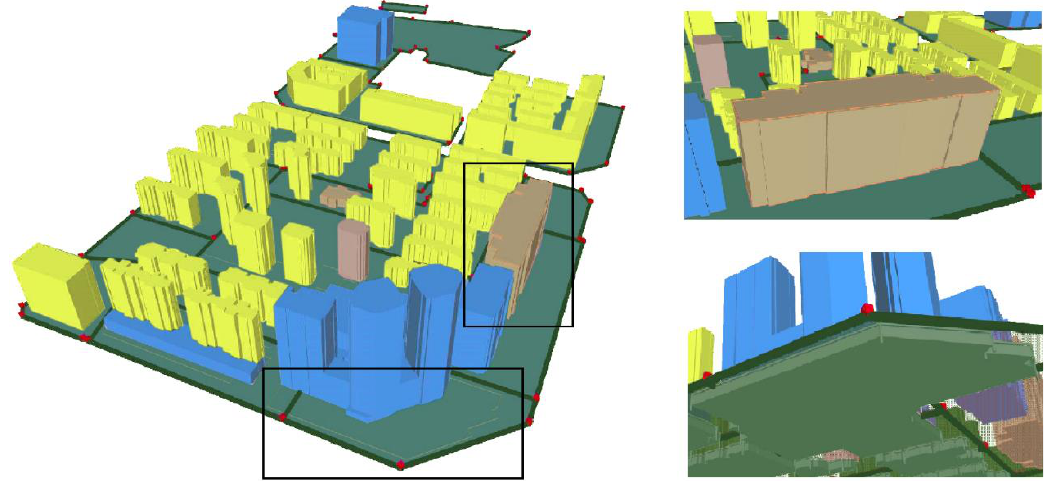
Figure 8. A cartographically enriched 3D scene corresponding to the urban cadastre scenario demonstrated in Figure 7. The symbolic rules applied are listed in Table 2. Table 2. The symbolic rules employed in Figure 8.